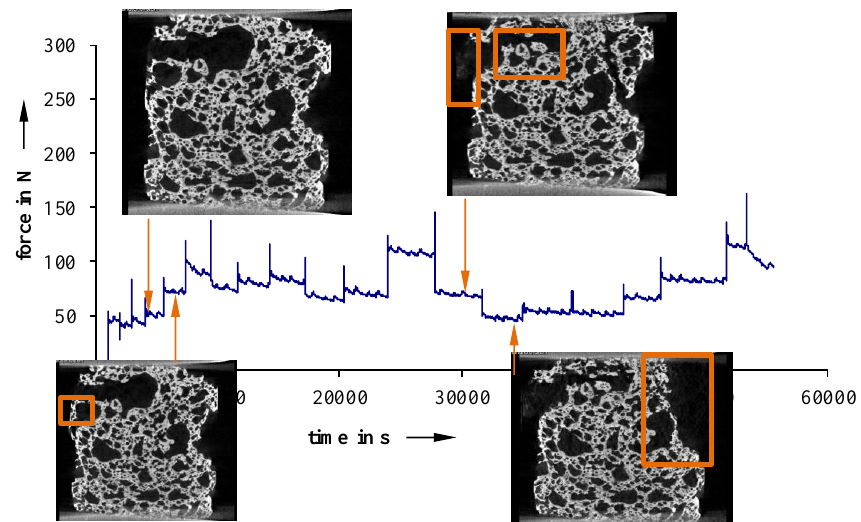
Figure 12. Recorded force-travel curves of compression tests conducted on an in situ µCT; 23 °C not devolatilized.